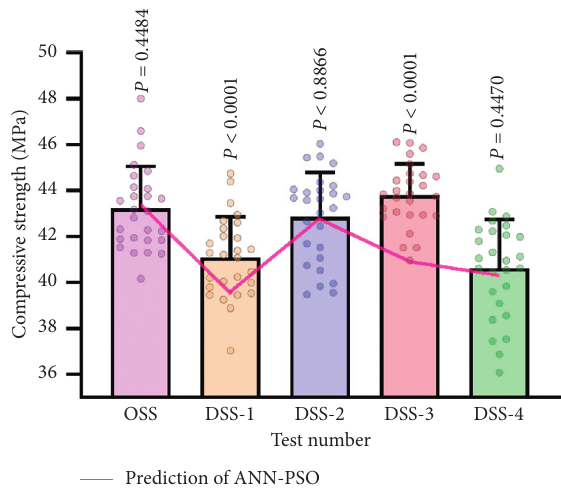
Figure 6: Comparison of the ANN-PSO model predicted value and actual test